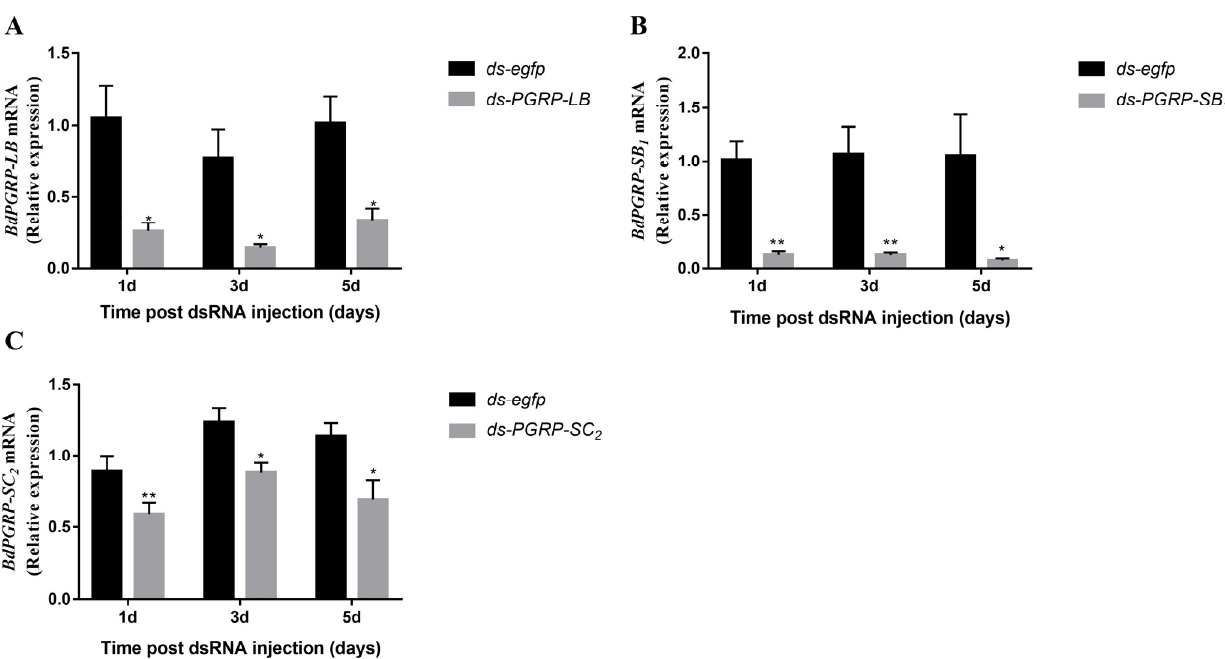
Figure 5. RNA interference efficiency of BdPGRPs . Relative expression of PGRP-LB ( A ), PGRP-SB 1 ( B ), and PGRP-SC 2 ( C ) after dsRNA injection at different time points with whole body samples. All error bars represent the SEM of the mean of three independent biological replicates. Statistical analysis was based on Student’s t -test. * p < 0.05; ** p < 0.01. The relative gene expression data were analyzed using a 2 − ∆∆ CT method and the data were normalized to reference gene Rpl32 .